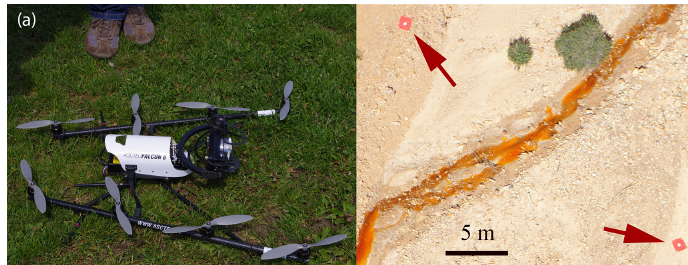
Figure 4. (a) The Astec Falcon 8 UAV and (b) carpets with reflectors used as GCPs for exterior orientation. Table 2. Information about both UAV epochs. Mean point density Number of Number of UAV Number of Number of per 0.01m 2 ( σ )/ total points total points campaign pictures tie points m − 2 ( σ ) (filtered) (unfiltered) for exterior (filtered data) orientation